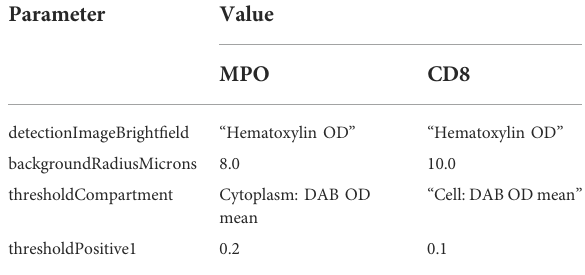
TABLE 1 QuPath Positive cell detection parameters for MPO (neutrophils) and CD8 (T-cells) positive detection,